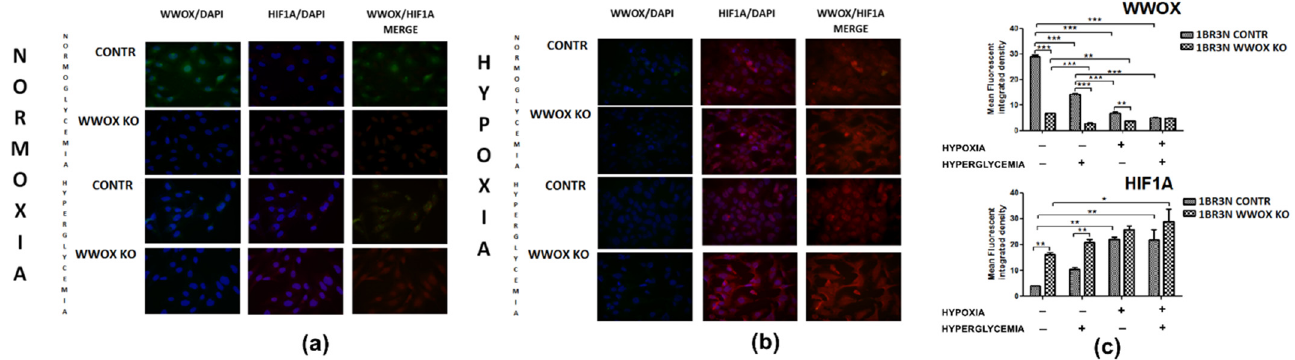
Figure 8 . Immunocytochemistry analysis of WWOX and HIF1 α in 1BR.3.N CONTR and WWOX KO cells after 6h incubation in normoxia ( a ) and hypoxia ( b ). Calculation of Total Corrected Cell Fluorescence (TCCF) ( c ). Results of ANOVA with a post-hoc Tukey-Test are shown as mean ± SEM. *, p < 0.05; **, p < 0.01; ***, p < 0.001.